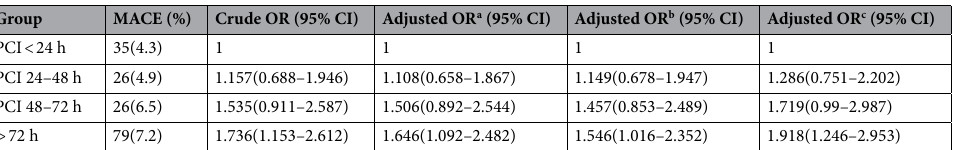
Table 4. Multivariate logistic regression analysis of in-hospital MACEs. Adjusted for variables that Stepwise Multiple Logistic regression p-remove > 0.2 and p-enter < 0.1. a sex, age. b Sex, age, smoking, diabetes mellitus, hypertension, dyslipidemia, renal insufficiency, prior MI, PCI, CABG, COPD, CHF, PAD. c Sex, age, smoking, diabetes mellitus, hypertension, dyslipidemia, renal insufficiency, prior MI, PCI, CABG, COPD, CHF, PAD, ASA, clopidogrel, beta-blocker, statin, angiotensin converting enzyme inhibitor, GP IIb/IIIa antagonist, anticoagulant drugs.